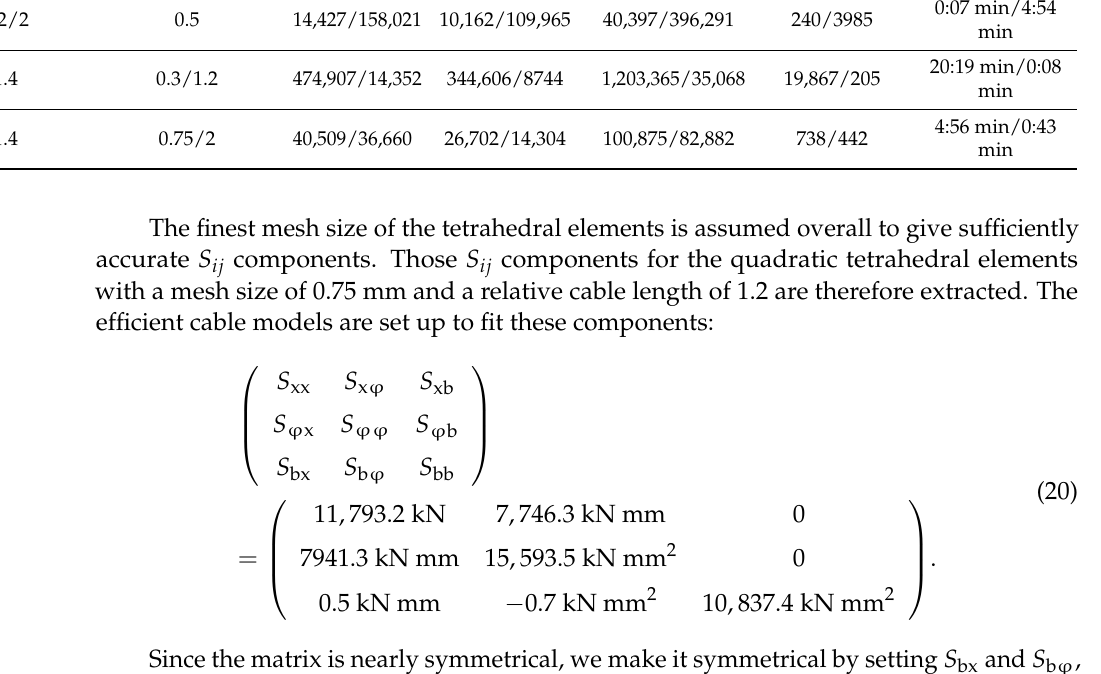
length, and mesh results took about 5 min to compute. Table 4. Information on the model size, necessary RAM to load the full stiffness matrix, and com ‐